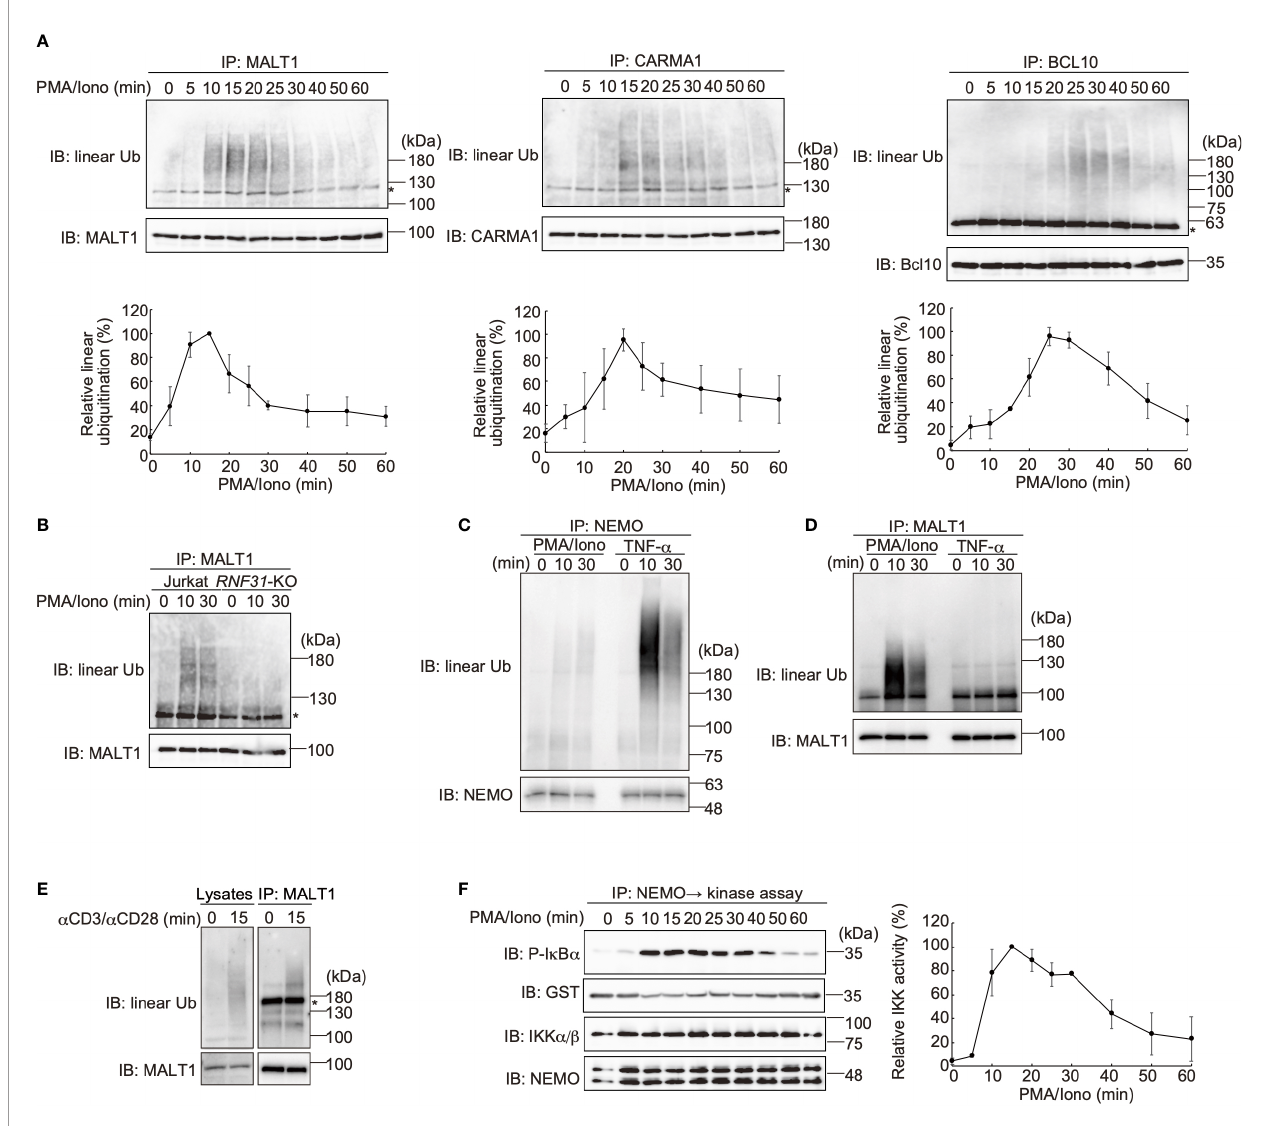
FIGURE 4 | The CBM complex is linearly ubiquitinated upon TCR stimulation. (A) Parental Jurkat cells were stimulated with 20 ng/ml PMA and 150 ng/ml ionomycin for the indicated time periods. The heat-denatured cell lysates were immunoprecipitated and immunoblotted with the indicated antibodies. Taking the maximum intensities of linear ubiquitination as 100%, the relative intensities of the linear ubiquitinated CBM complex are indicated. Means ±SD ( n = 3). (B) HOIP is required for linear ubiquitination of MALT1. Parental and RNF31 -KO Jurkat cells were stimulated with PMA/ionomycin as in (A) , immunoprecipitated with anti-MALT1, and immunoblotted with the indicated antibodies. (C) Suppressed linear ubiquitination of NEMO in the TCR-mediated NF- k B activation pathway. Jurkat cells were stimulated with 20 ng/ml PMA and 150 ng/ml ionomycin or 1 µg/ml TNF- a for the indicated time periods, and cell lysates were immunoprecipitated with an anti-NEMO antibody and then immunoblotted with the depicted antibodies. (D) MALT1 is exclusively linearly ubiquitinated upon TCR stimulation. A similar analysis to that in Figure 4C was performed after anti-MALT1 immunoprecipitation. (E) Linear ubiquitination of MALT1 after stimulation with CD3 and CD28. Jurkat cells were stimulated with 5 µg/ml each of anti-CD3 and anti-CD28 antibodies as indicated. The cell lysates and anti-MALT1 immunoprecipitates were immunoblotted by the indicated antibodies. (F) Transient activation of canonical IKK. Jurkat cells were stimulated with 20 ng/ml PMA and 150 ng/ml ionomycin for the indicated time periods. After immunoprecipitation with an anti-NEMO antibody, an in vitro canonical IKK assay was performed using GST-I k B a 1 – 54 as the substrate. Samples were immunoblotted with the indicated antibodies, and taking the maximum intensities of P-I k B a as 100%, the relative intensities are indicated. Means ±SD ( n = 3). (A, B, E) *; nonspeci fi c